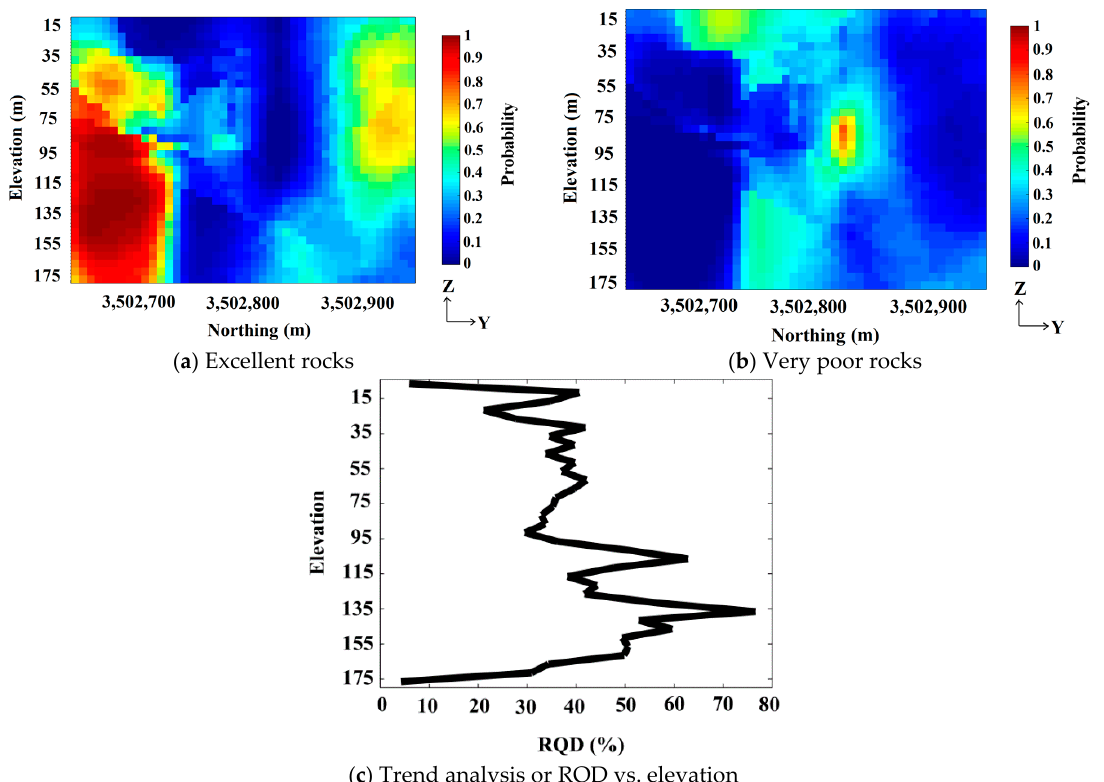
Figure 12. Probability maps produced from multi-Gaussian kriging for two different rock qualities in vertical section (Easting: 401,411 m).